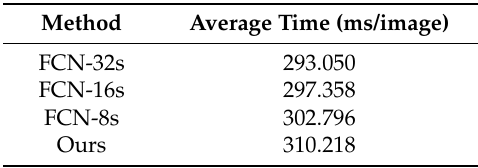
Table 1. Time-consuming of four